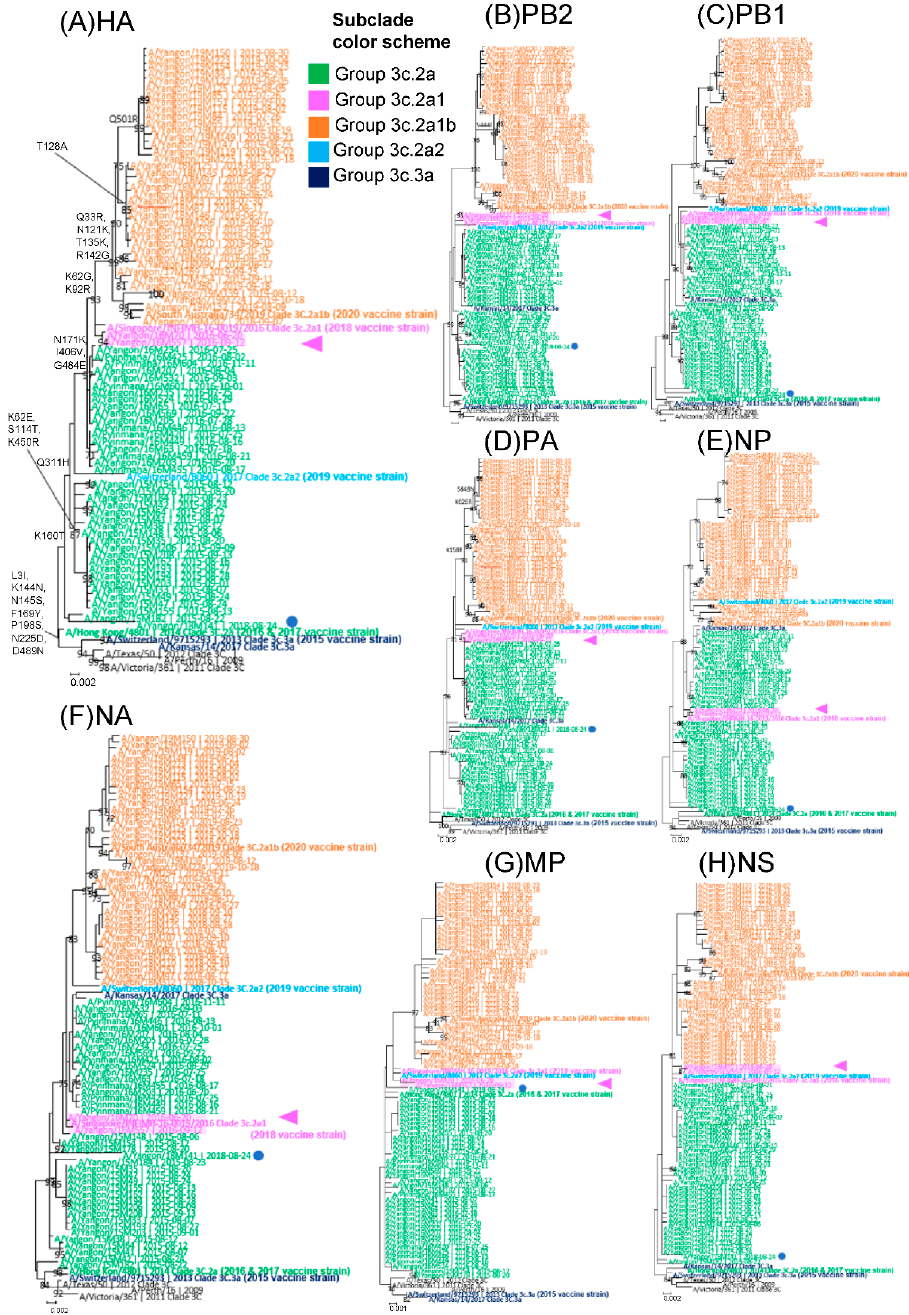
Figure 1. Maximum-likelihood phylogenetic trees of all eight segments of influenza A/H3N2 viruses circulating in Myanmar and comparison of sequences from 79 strains isolated in Myanmar between 2015 and 2019 and to the Southern Hemisphere vaccine strains of known clades recommended by the WHO. Southern Hemisphere vaccine strains from 2015 to 2019 are indicated by bold letters according to clade classification by the WHO. ( A ) HA, ( B ) PB2, ( C ) PB1, ( D ) PA, ( E ) NP, ( F ) NA, ( G ) MP, and ( H ) NS segments. Amino acid substitutions compared to A/Texas/50/2012 were indicated in HA. The two strains that belonged to 3c.2a1 are highlighted in pink and denoted by pink triangles to clarify the topologies concerning 3c.2a and 3c.2a1b viruses. One revival strain, A/Yangon/18M141/2018, is marked with blue circles. The phylogenetic tree was inferred by the maximum-likelihood method using 1000 bootstrap replicates implemented in MEGA v.7.0.26. Branch values > 70% are indicated at the